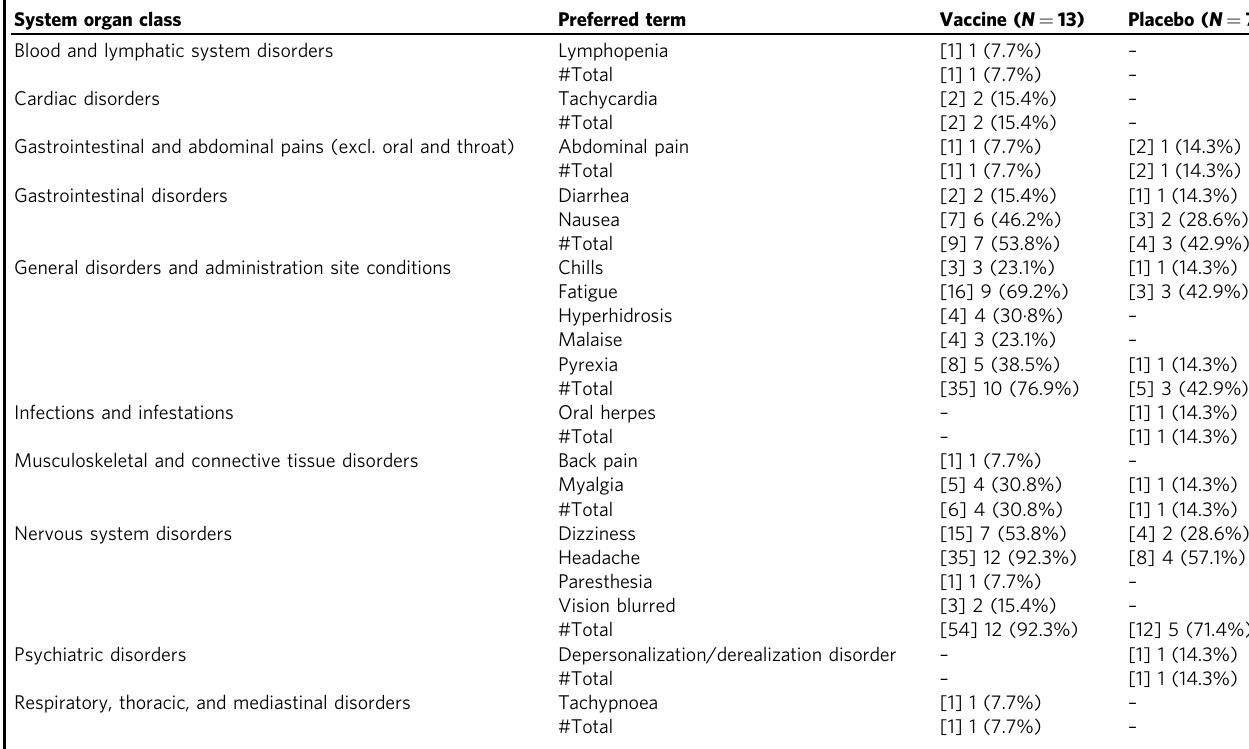
Table 2 Related grade 1 and 2 AEs using MedDRA terminology during the immunization phase Days − 2 to + 42).